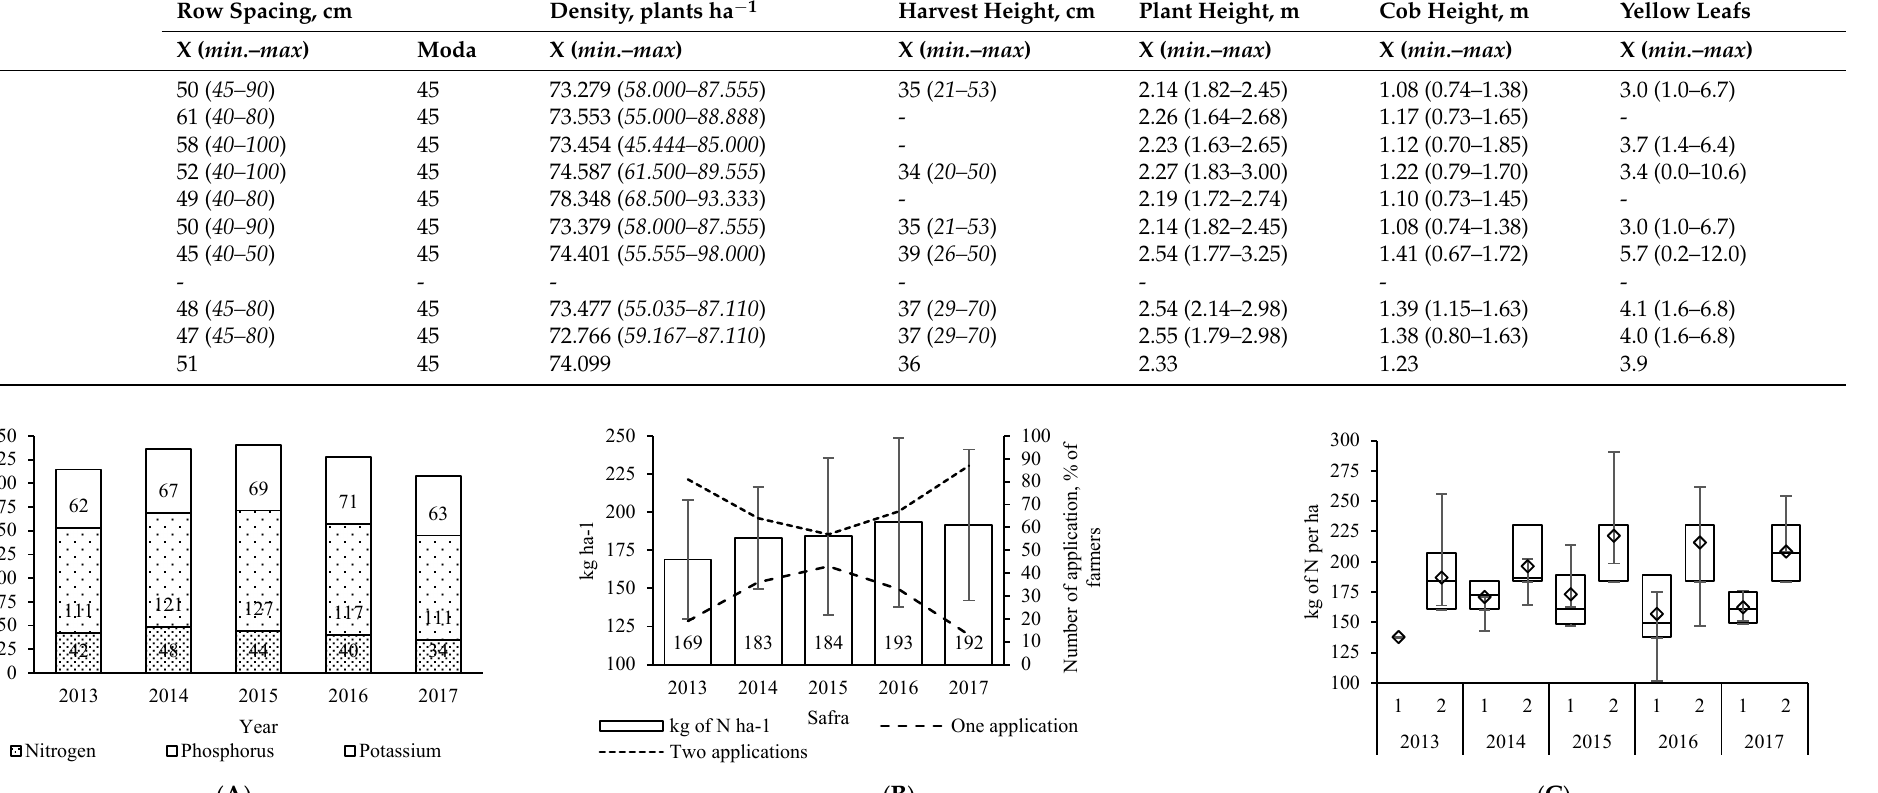
Table 4. Planting, harvesting, and morphometric characteristics of corn plants cultivated in the state of Paraná, Brazil for silage production between the years 2011